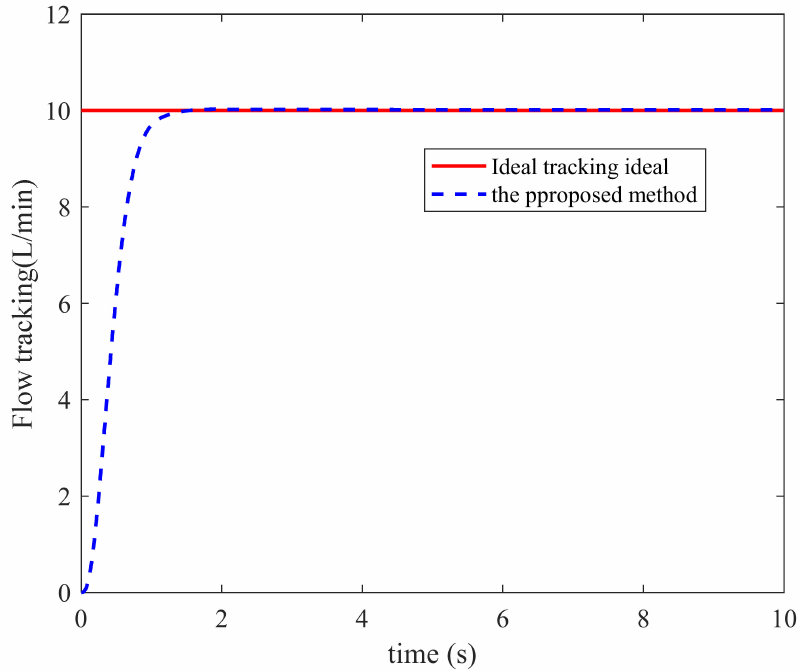
Figure 14. Time response of glue flow tracking.